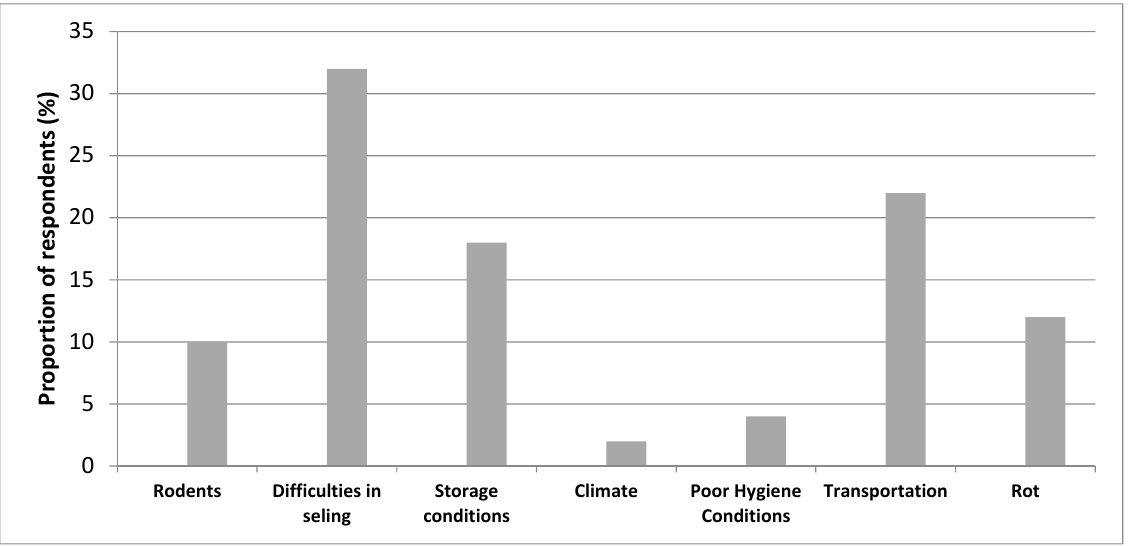
Figure 6. Causes of fruit waste during handling by retailers ( n = 50).